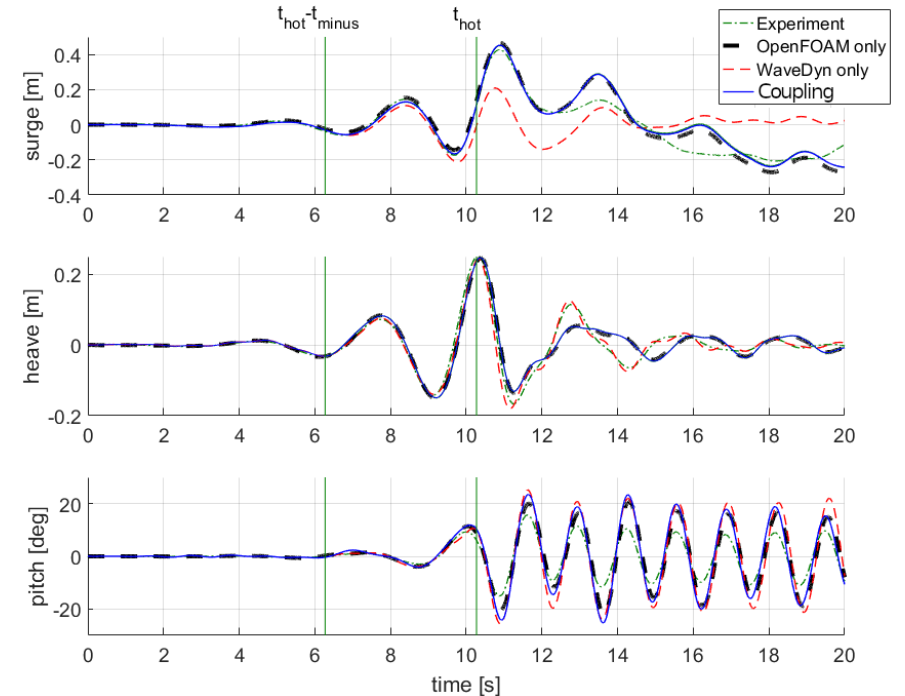
Figure 15. Comparison of numerical models motion responses prediction time-series using ST 1 case. | indicate hot-start time ( t hot ) and when coupling starts ( t hot − t minus